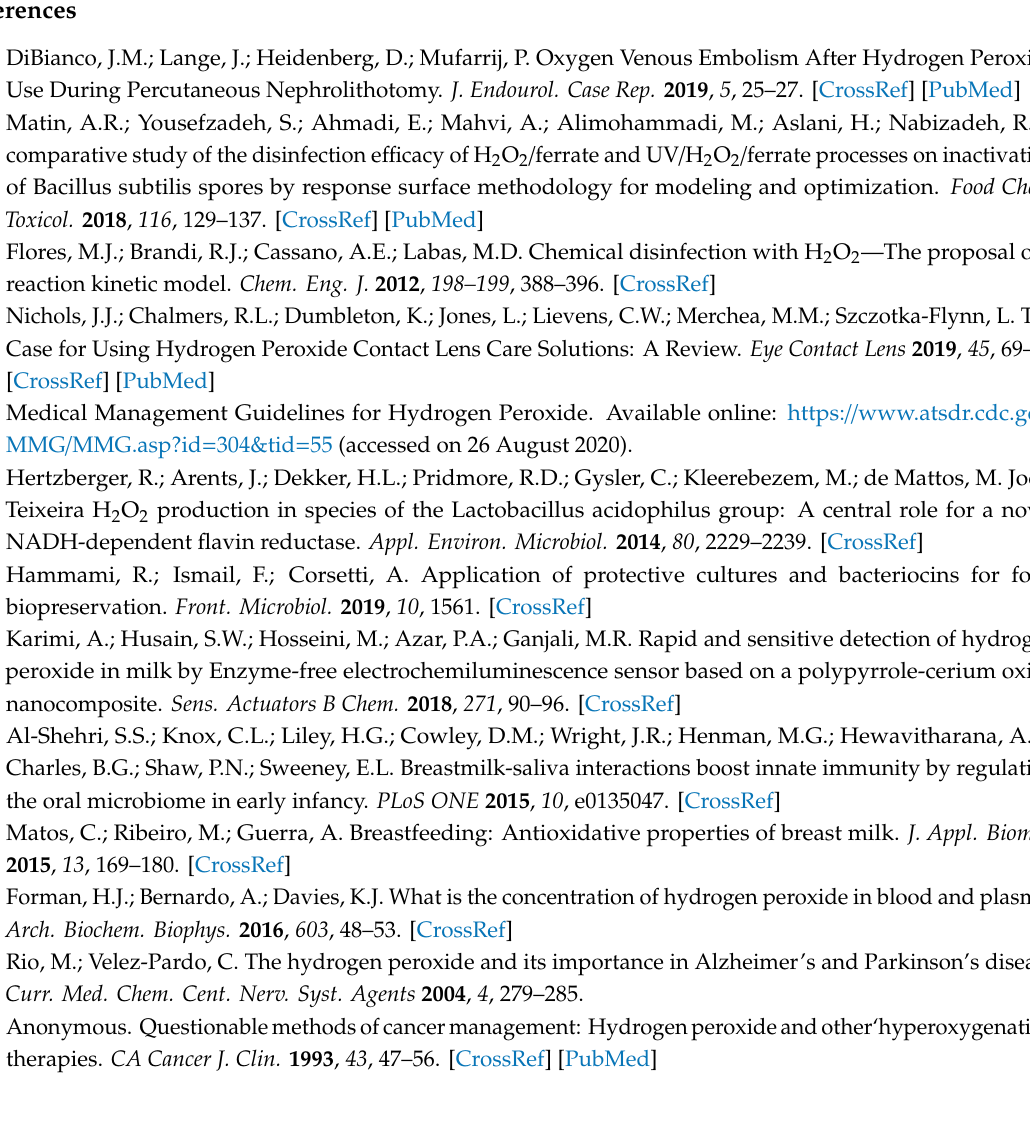
Figure S1: Scanning electron microscopy and Figure S2: Elemental mapping (single layer) of Ag, O, C, S and N of Algae-AgNPs prepared by nanoprecipitation of 7:3 v / v of algae extract / 0.1 M AgNO 3 , Figure S3: Energy-dispersive spectroscopy (EDS) spectra and atomic ratio of corresponding elements in the Algae-AgNPs, Figure S4: Photographs of Algae-AgNPs exposed to di ff erent interfering species with H 2 O 2 , showing H 2 O 2 with the only noticeable change in color. Initial concentration of 10.0 nM, time of equilibrium 40